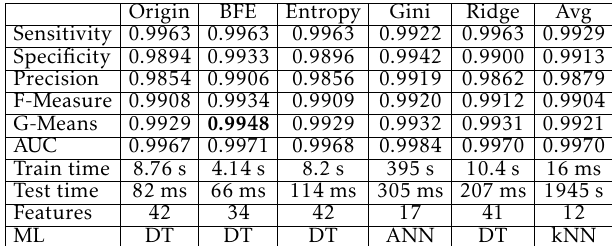
Table 38. Compare IG-BFE with other algorithms on GENERIC.